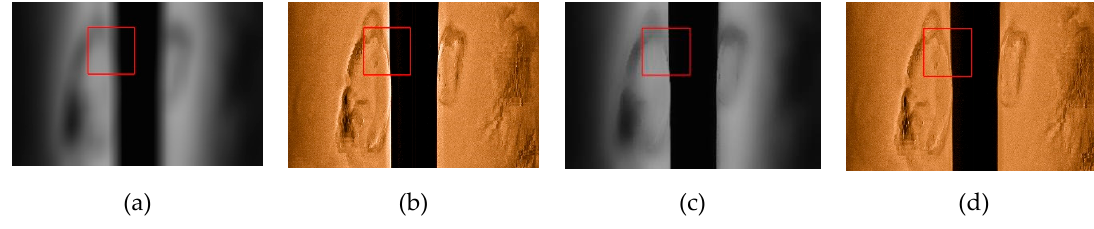
Figure 7. Experimental comparison of images. (a) Smoothed image using mean filter, (b) mean method results, (c) smoothed image using bilateral filter, and (d) bilateral method image.